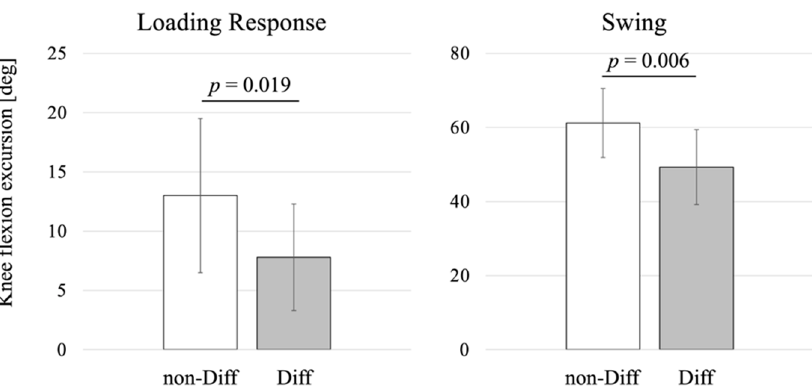
Figure 2. Comparison of knee flexion excursions in loading response and swing between the groups with walking difficulty (Diff) and without walking difficulty (non-Diff).